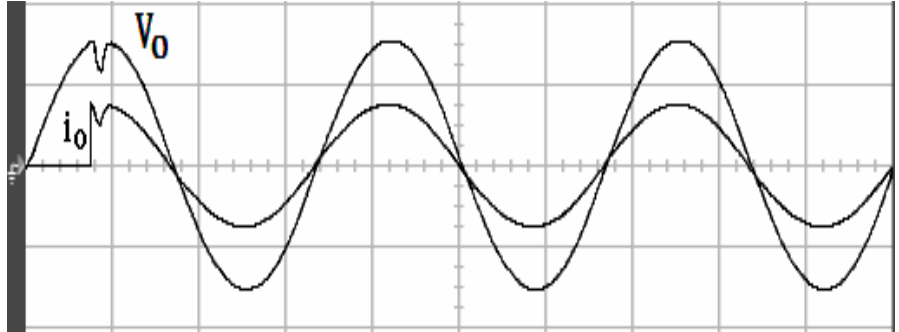
Figure 9. Output voltage and current for experiment of the conventional limited ‐ time convergent VSC from no load to full load (vertical: 100 V/div and 20 A/div; horizontal: 5 ms/div).